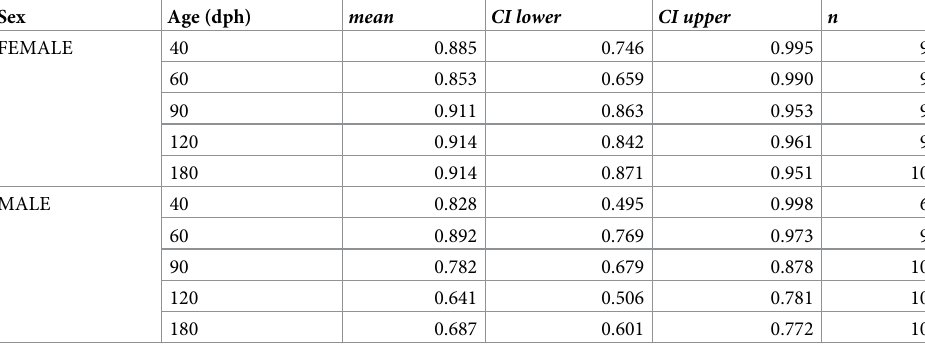
Table 1. The numerical description of phonotaxis data shown in Fig 2A.